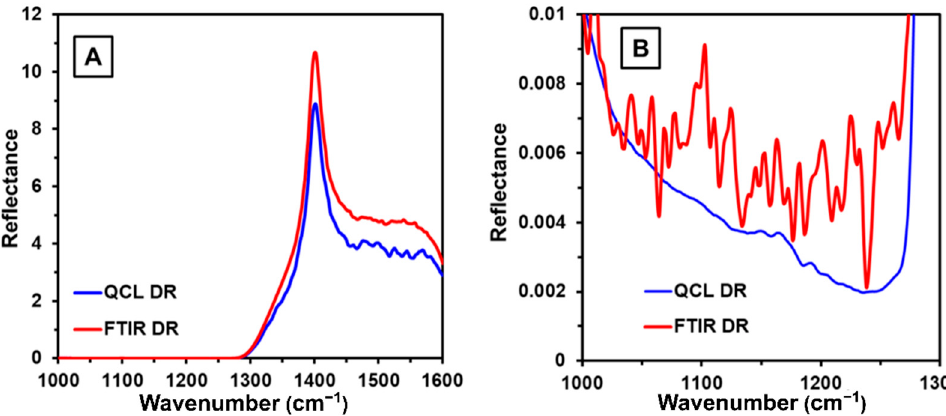
Figure 2. Comparing the spectroscopic instruments and modes (DR, diffuse reflectance; TR, trans- mission) used for the characterization of C-SiO 2 : FTIR and QCL. ( A ) Spectral range from 1000 to 1600 cm − 1 ; ( B ) zoom of the spectral range from 1000 to 1300 cm − 1 .